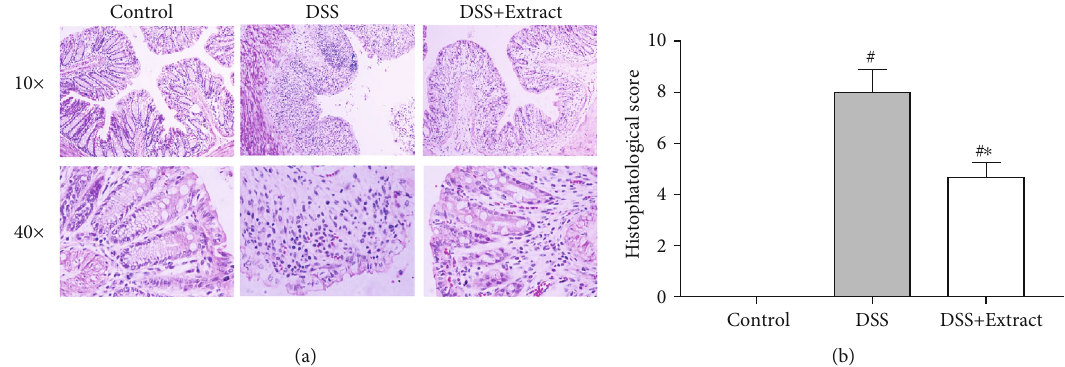
Figure 3: (a) Representative para ffi n sections of colonic tissue from each group by hematoxylin and eosin staining. Observations were made under a microscope at 10x and 40x. (b) Histopathological score. The data shown are the mean values for each group ( n = 6 ). ∗ represents signi fi cant di ff erences vs DSS group ( P < 0 : 05 ) and # P < 0 : 001 vs Control group (one-way